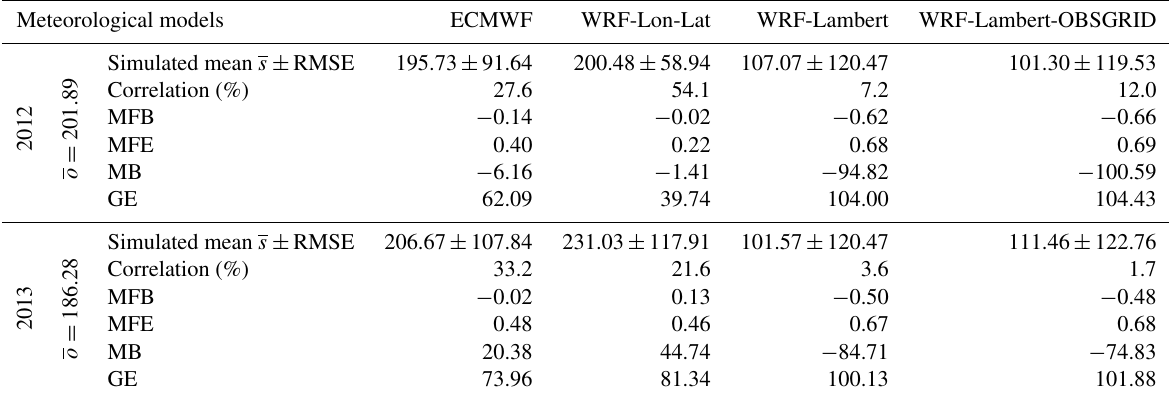
Table 5. Wind direction statistics for the four meteorological models at Ersa during the 2012 and 2013 summer campaigns. The wind direction means and the RMSEs are in degrees. o refers to the measured mean.